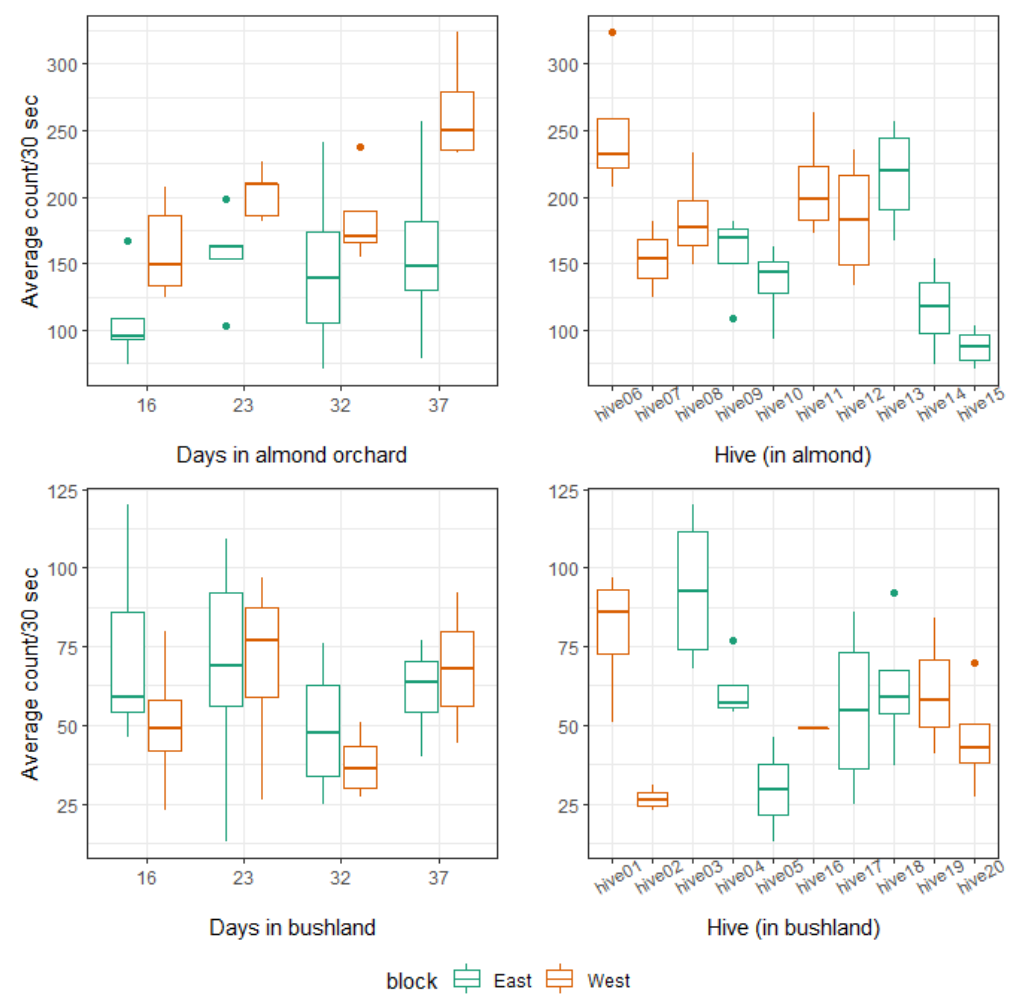
Figure 5. Mean honey bee counts per 30 s calculated in the period prior to the indicated days after placement, in either an almond orchard (top) or in bushland (bottom), and for average honey bee counts per 30 s for each hive in the study over all sampling intervals. Color legend indicates the direction that hives faced at the site (east or west).